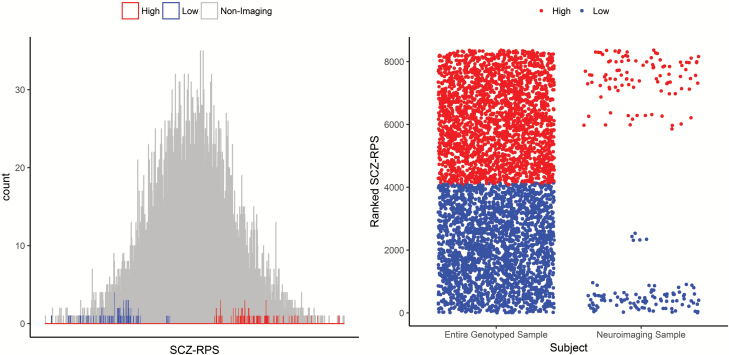
Characterization of the schizophrenia polygenic risk group in the neuroimaging sample (calculated by SCZ-RPS—left; defined by rank—right; N = 197; low = 99, high = 98) compared to the entire genotyped cohort (N = 8169, not including the neuroimaging sample).